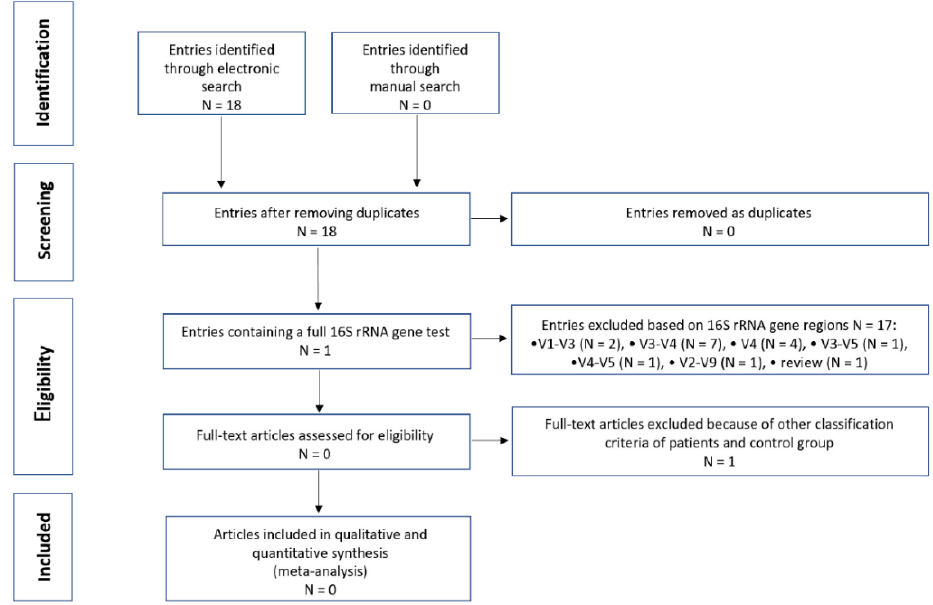
Figure 7. Flowchart of literature search. N—number of entries (research manuscripts). V1–V9— hypervariable regions of the 16S rRNA gene .